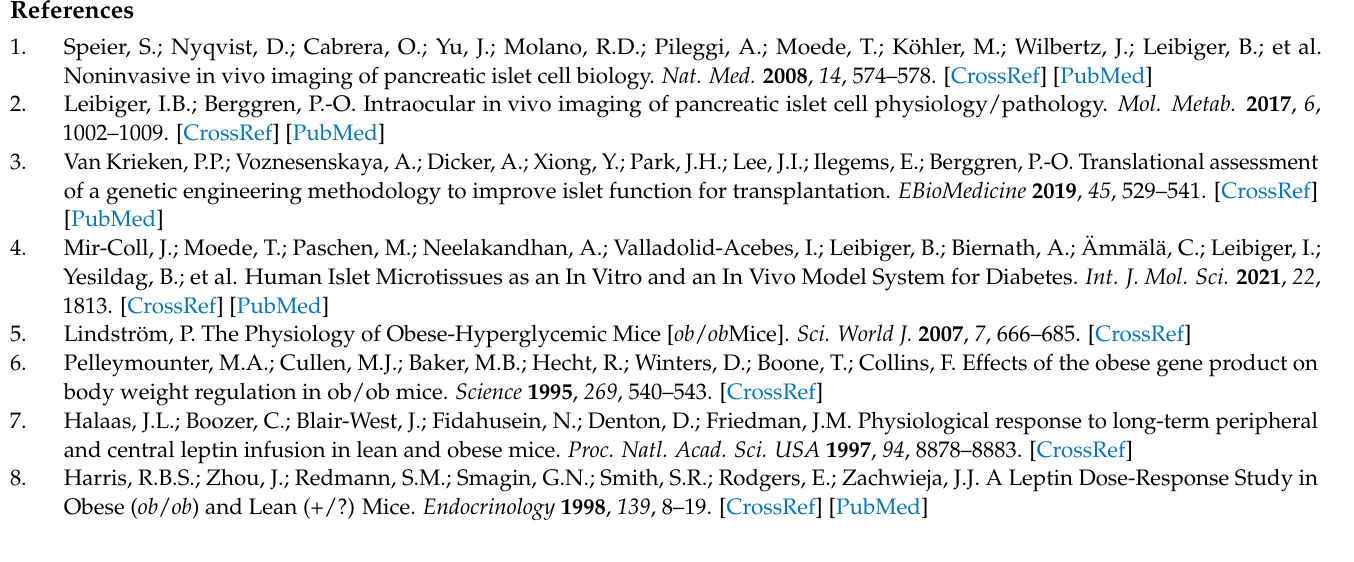
Figure A2. Additional information related to Figure 3. ( a ) Timeline of the second set of experiments. ( b ) Individual traces from the ipGTTs summarized as AUC in Figure 3d. Data are expressed as mean ± SEM. Data points that include saturated glucose measurements are labeled with #. * p < 0.05; ** p < 0.01; *** p < 0.001; n = 7 for transplanted and 5 for control group. ( c ) Plasma leptin levels of transplanted mice over the period of the experiment, n = 3–7 .